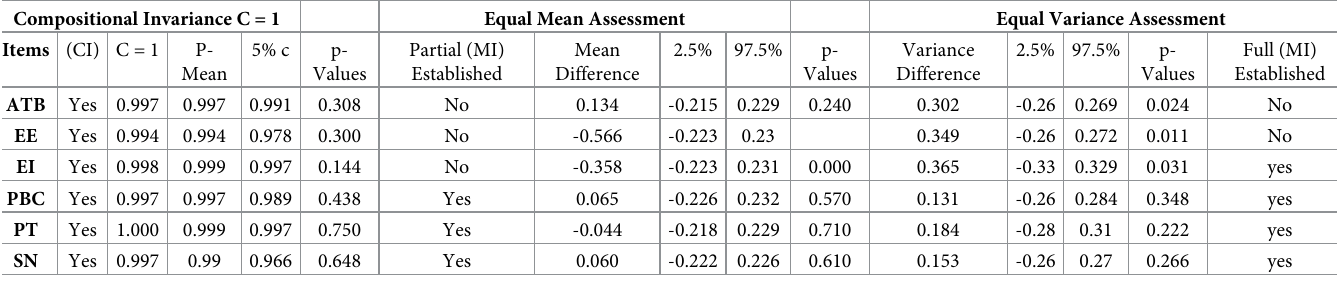
Table 9. Permutation test for measuring invariance. Compositional Invariance C =